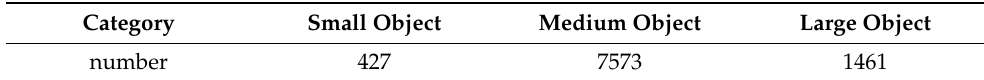
Table 3. Number of each category.